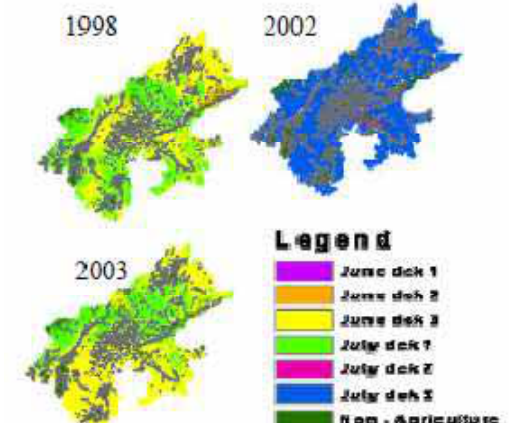
Fig. 2 Spatial variation in start of season (SOS) over eastern Rajasthan